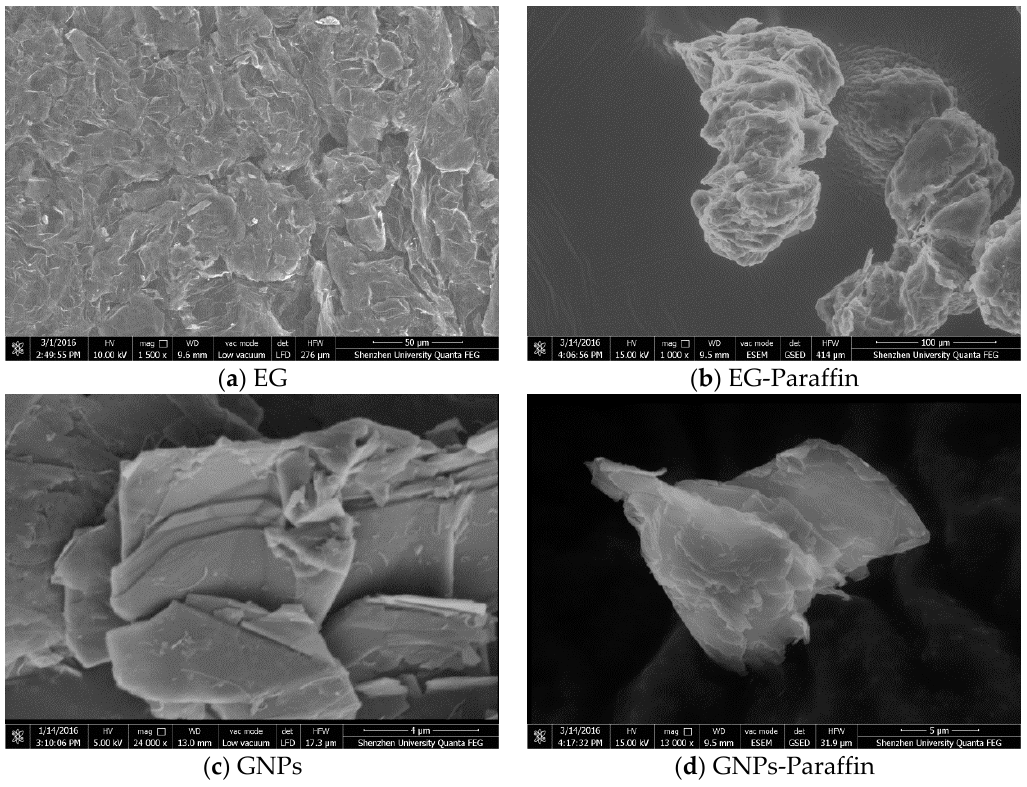
Figure 2. SEM micrographs of ( a ) expanded graphite (EG); ( b ) EG-Paraffin CPCM; ( c ) graphene nanoplatelets (GNPs); and ( d ) GNPs-Paraffin CPCM.